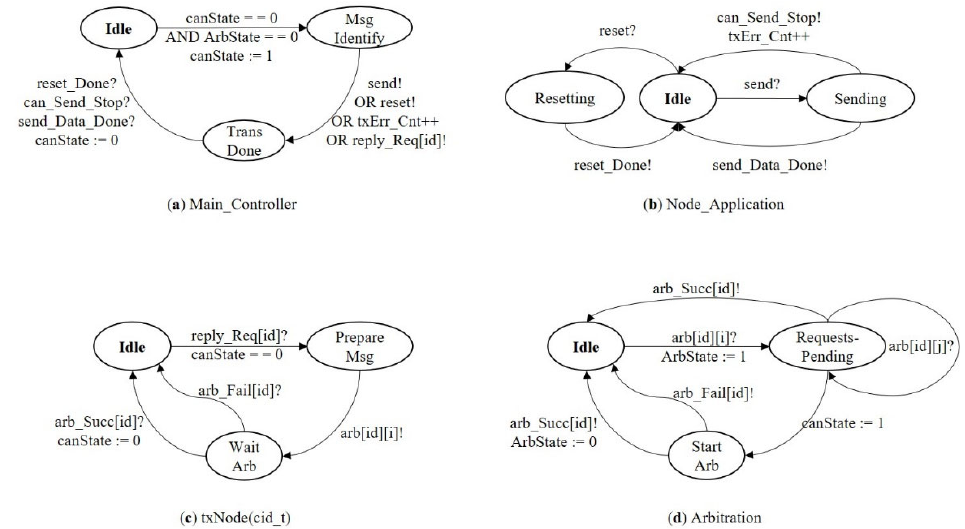
Figure 5. The interactive model of the CAN bus. ( a ) The state transitions of the master node. ( b ) The behavior patterns and state transitions of the nodes. ( c ) The state transitions of the slave node. ( d ) Arbitration state transitions.